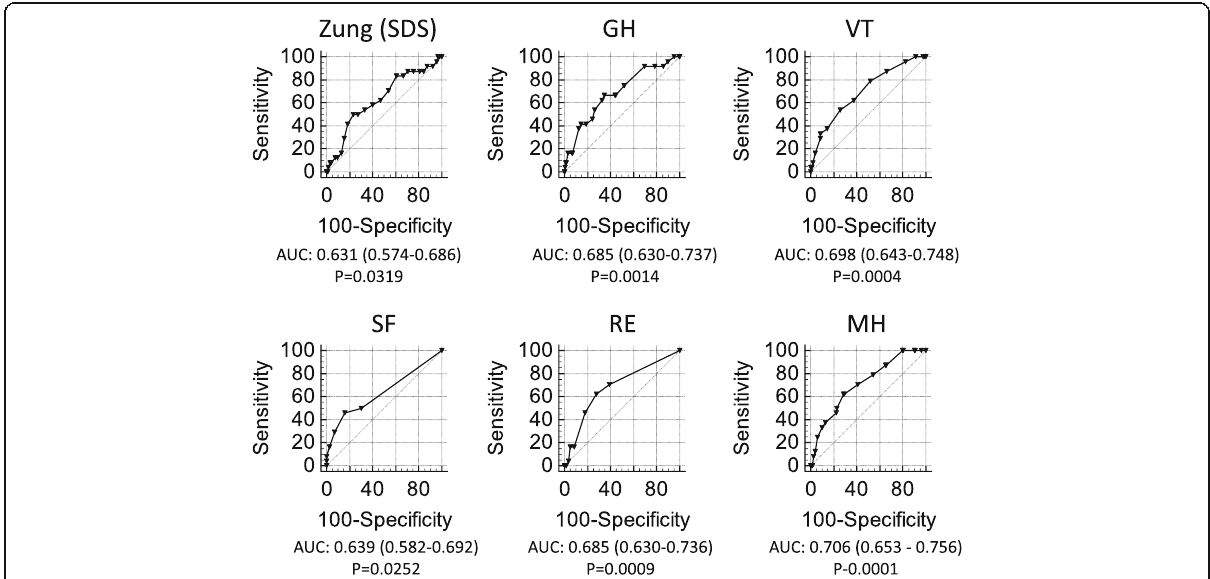
Fig. 2 Receiver operator characteristic (ROC) curves for the detection of MDD. The area under the ROC curve (AUC) is presented with 95% confidence intervals and p -values (Area = 0.5). SDS, Zung Self-Rating Depression Scale; Medical Outcomes Study 36-item Health Survey (SF-36) subscales: GH, general health perceptions (general health); VT, vitality; SF, social functioning; RE, role limitations due to emotional problems (role emotional); and MH, mental